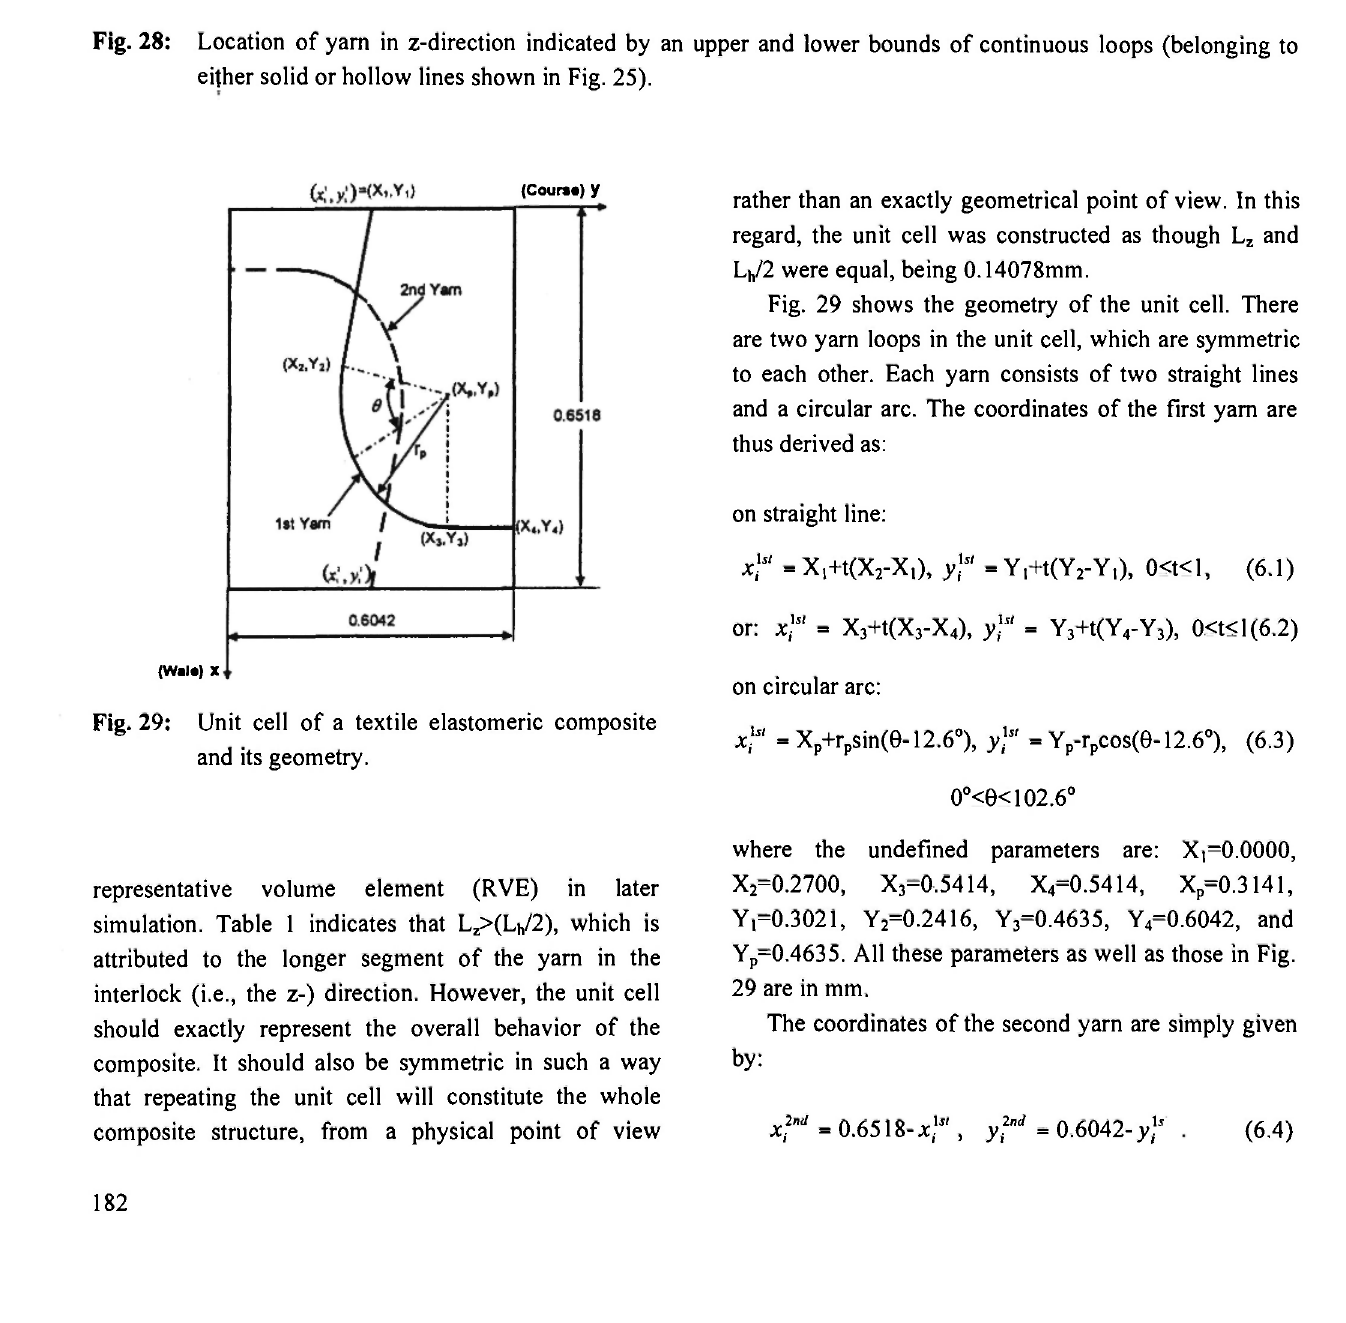
Fig. 28: Location of yarn in z-direction indicated by an upper and lower bounds of continuous loops (belonging to either solid or hollow lines shown in Fig. 25).